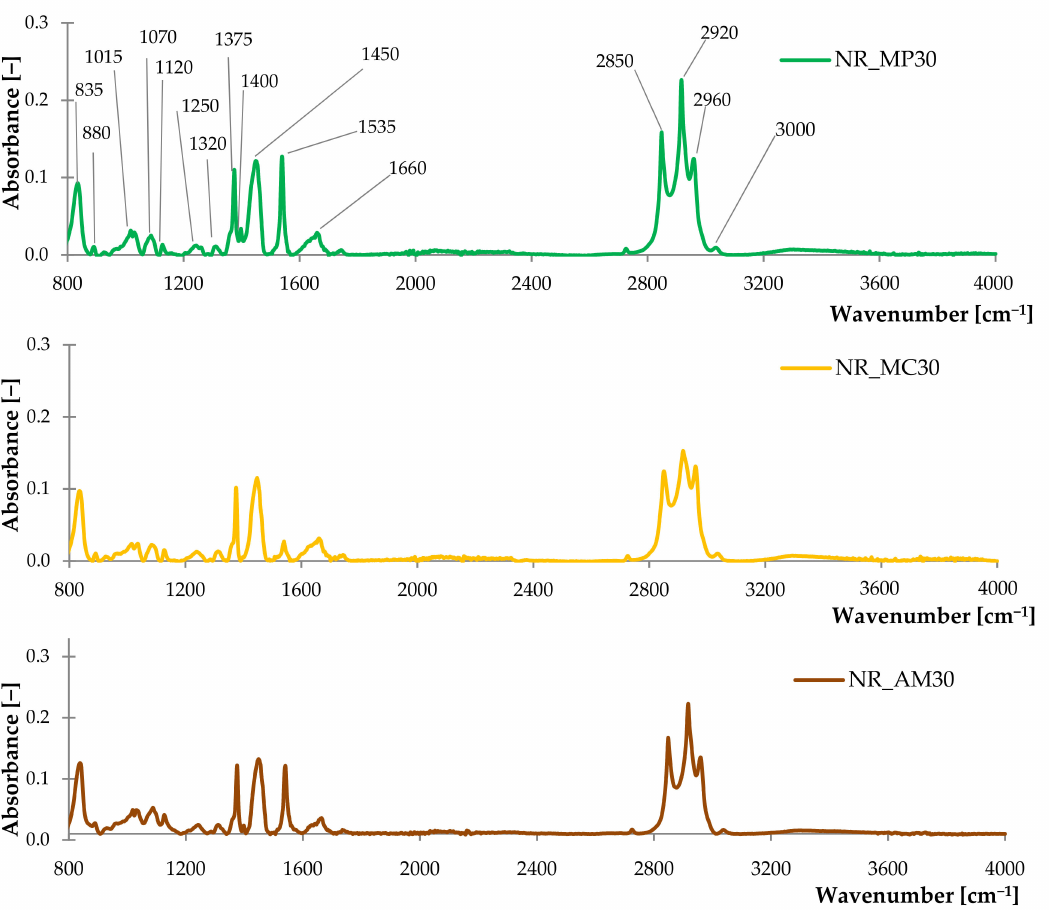
Figure 8. The FTIR spectra of composites filled with 30 phr of peppermint (NR_MP30), German chamomile (NR_MC30) and yarrow